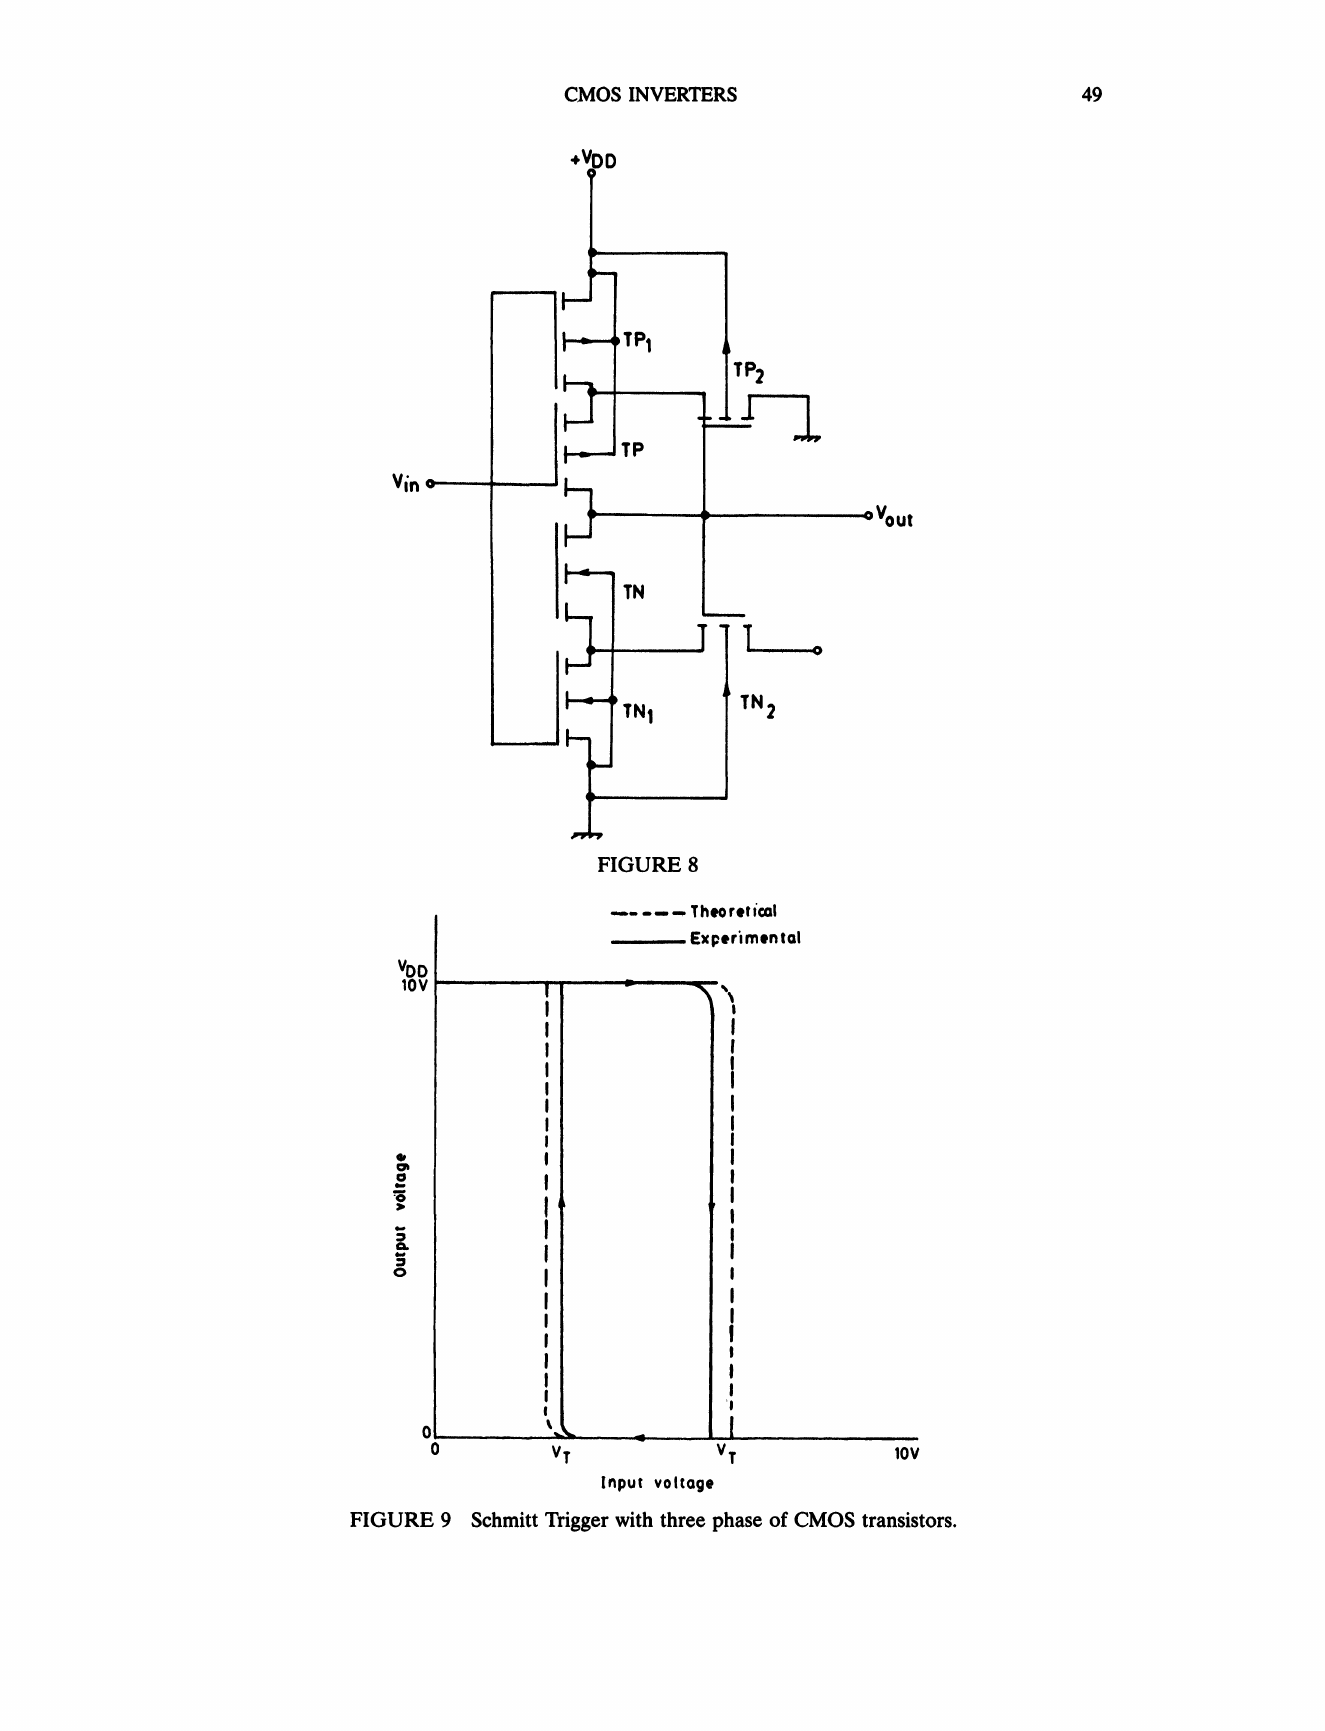
FIGURE 9 Schmitt Trigger with three phase of CMOS